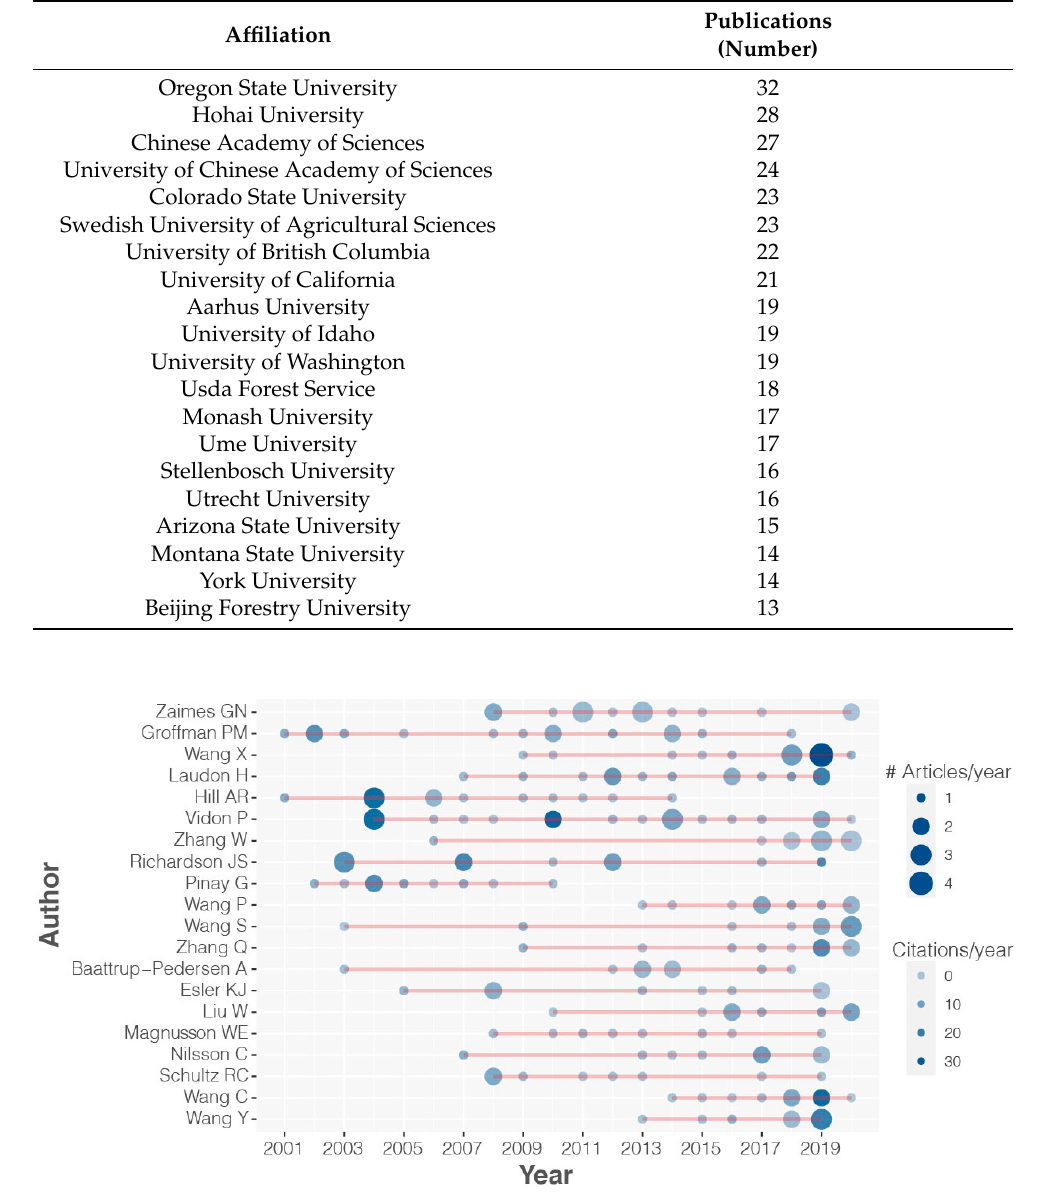
Table 2. Top institutions per number of published documents (2001–2020) based on the corresponding